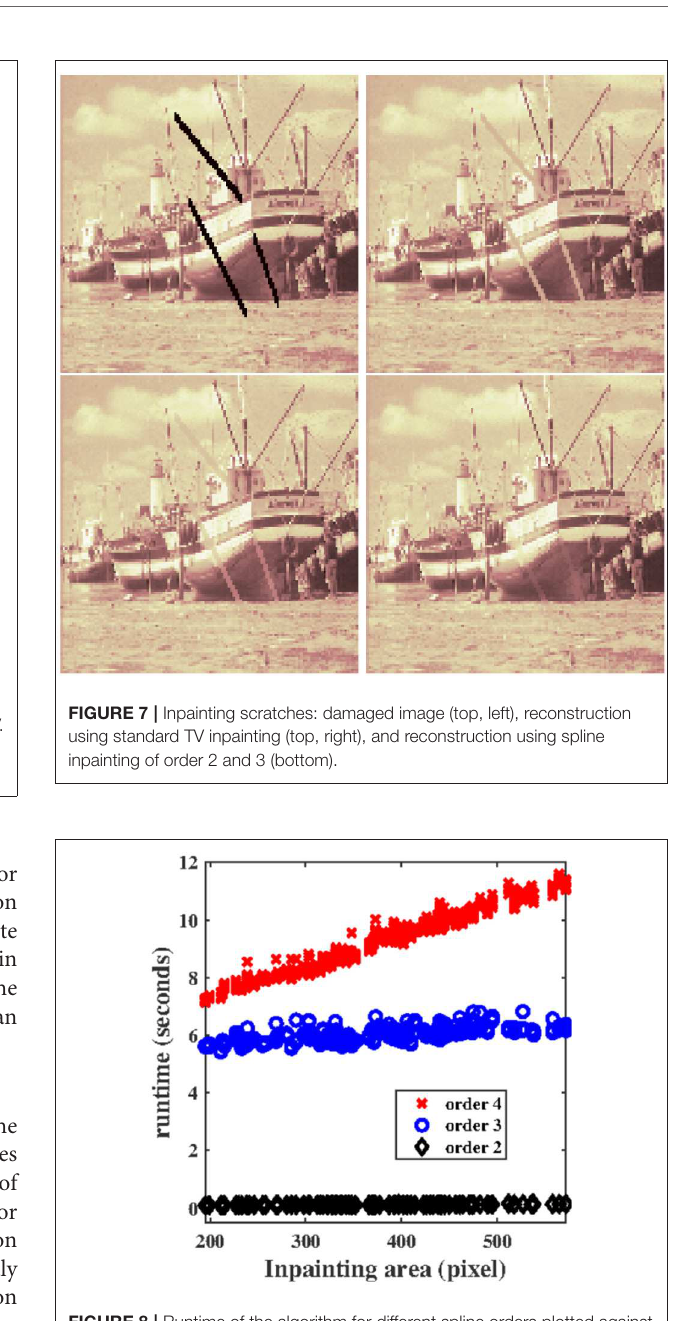
FIGURE 8 | Runtime of the algorithm for different spline orders plotted against the inpainting area in